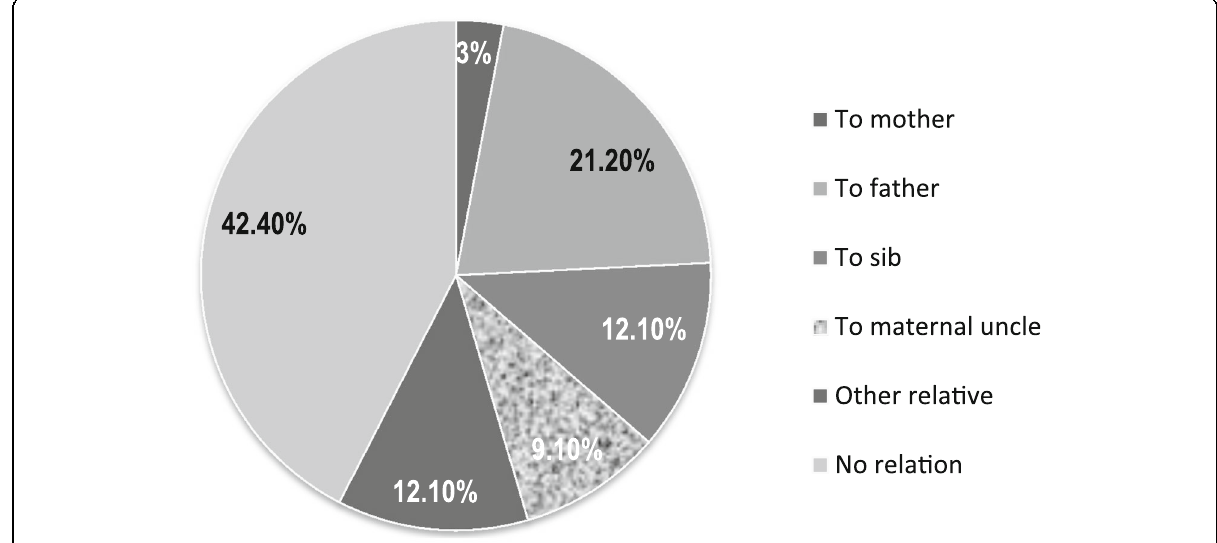
Fig. 1 The relation of donors to the